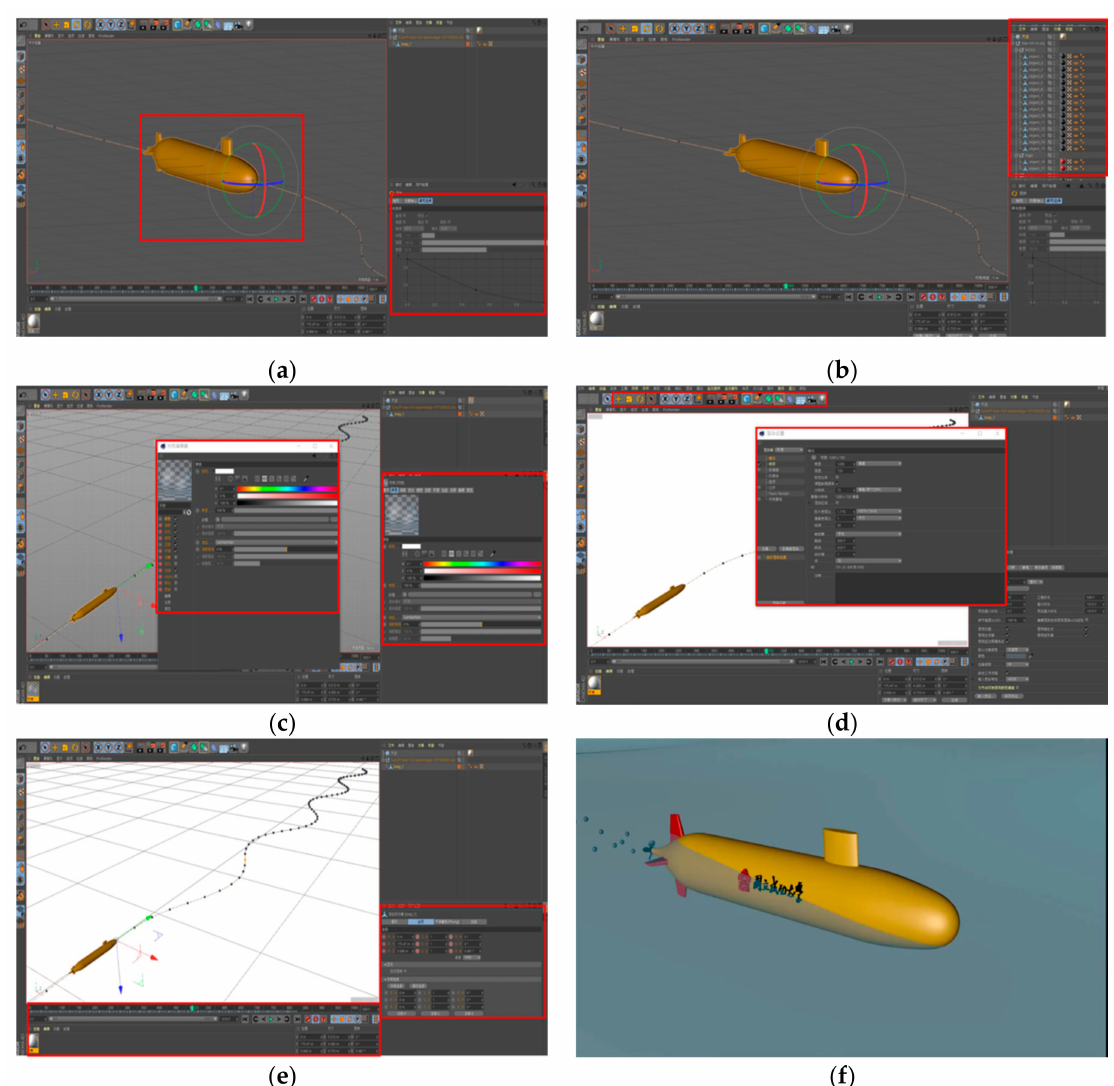
Figure 8. The operation steps of the Cinema 4D modelling: ( a ) layer-grid setting, ( b ) modelling-layer setting, ( c ) material and texture setting, ( d ) rendering and animation-recording setting, ( e ) animation frame rate and coordinate record point setting, and ( f ) real-time animation